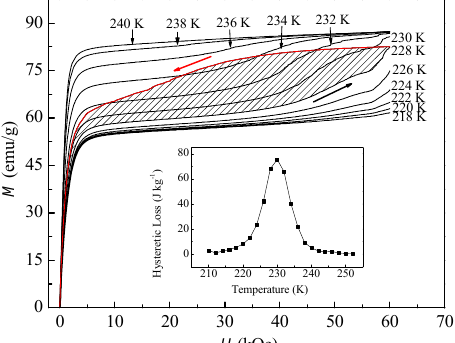
Figure 3. Isothermal M (H) of Ni The arrows indicate the direction of change of the applied field, and the shaded area represents the hysteretic loss for T = 228 K isotherm. The inset shows the hysteretic loss as a function of